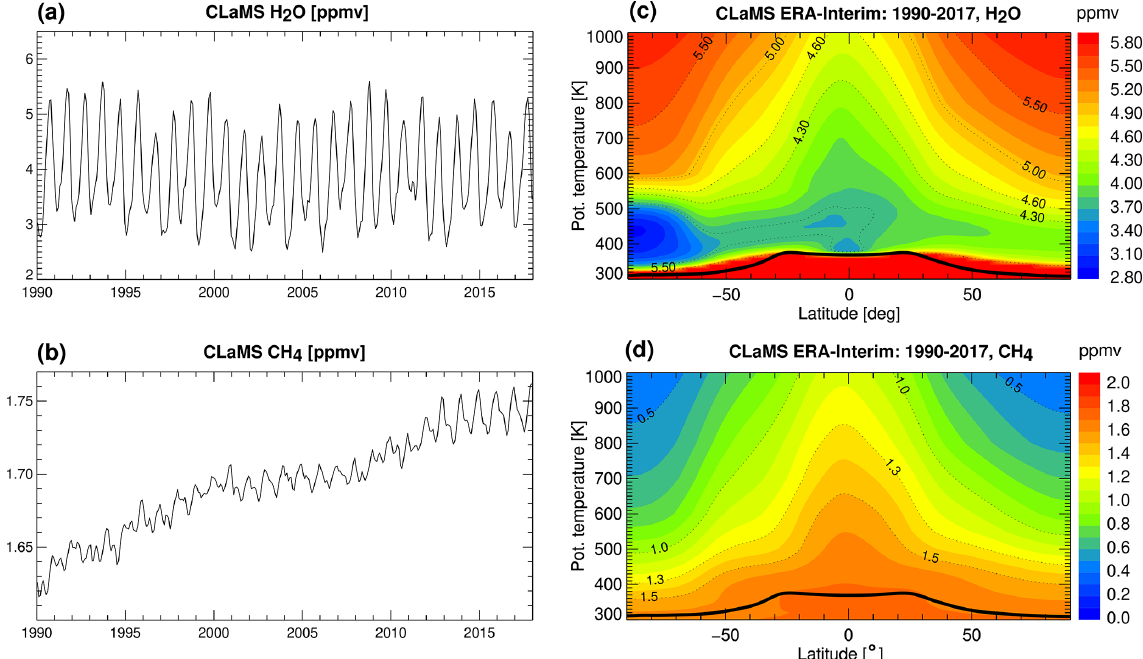
Figure 1. Time series of CLaMS stratospheric entry H 2 O and CH 4 . Time series of H 2 O (a) and CH 4 (b) mixing ratios (in ppmv) for 1990– 2017 averaged over the tropics at 30 ◦ S–30 ◦ N and in the potential temperature layer 390–400K. Annual zonal mean H 2 O distributions for H 2 O (c) and CH 4 (d) . Data shown are from the CLaMS simulation driven by ERA-Interim